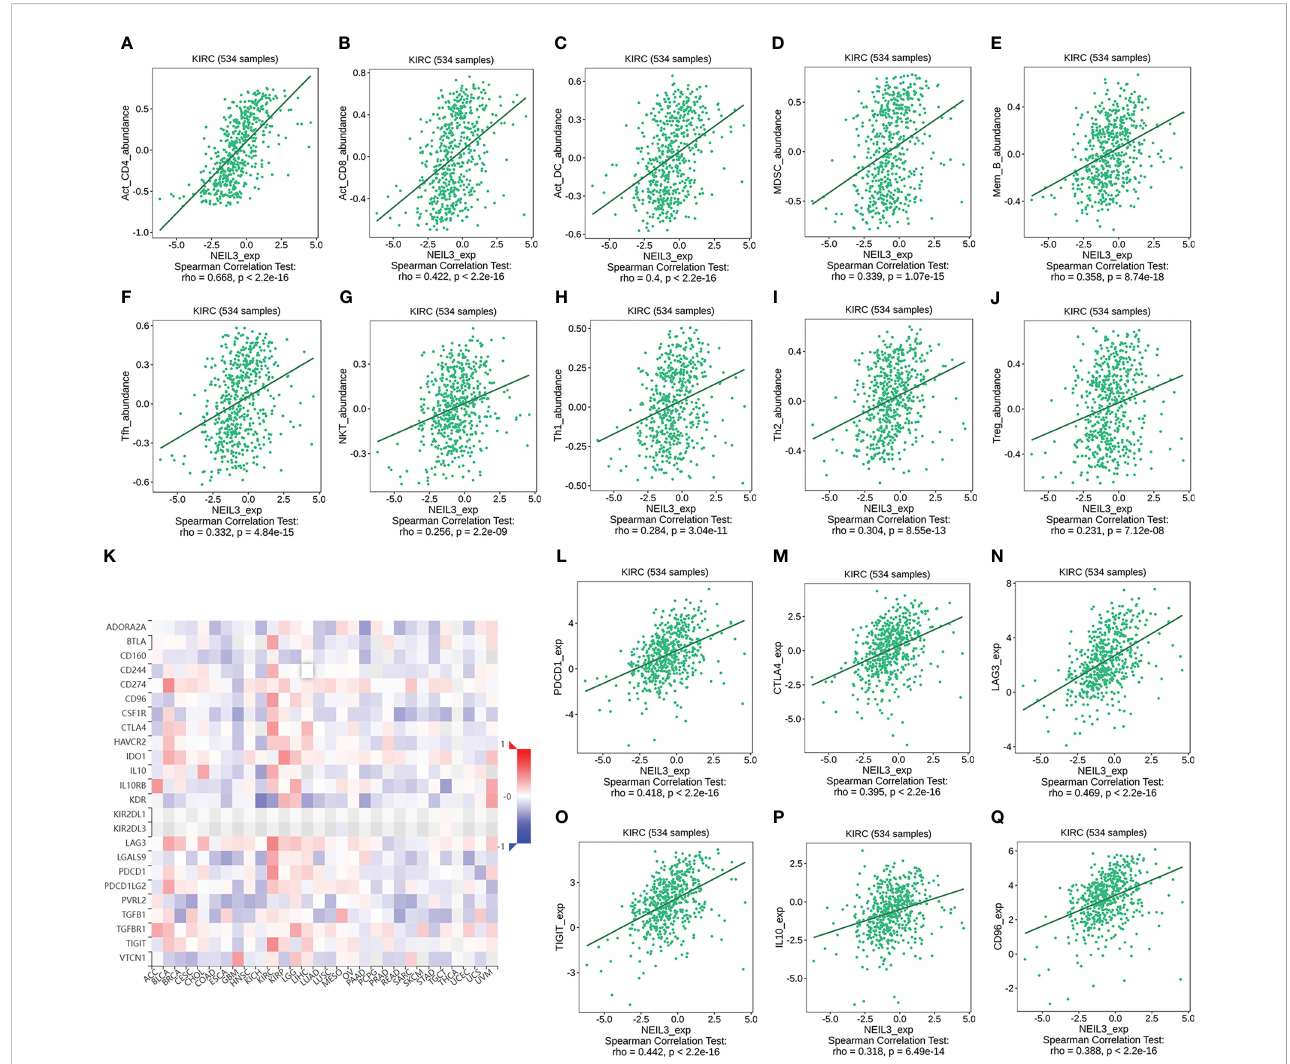
FIGURE 8 (A – J) Correlation analysis between the abundance of tumor-in fi ltrating lymphocytes (TILs) and NEIL3 expression using the TISIDB database. The results show that NEIL3 expression is positively correlated with activated CD4 T cells (r = 0.668, P < 2.2e-16), activated CD8 T cells (r = 0.422, P < 2.2e-16), activated dendritic cells (DCs) (r = 0.4, P < 2.2e-16), myeloid-derived suppressor cells (MDSCs) (r = 0.339, P = 1.07e-15), memory B cell (r = 0.358, P = 8.74e-18), follicular helper T cells (Tfhs) (r = 0.332, P = 4.84e-15), NKT cells (r = 0.256, P = 2.2e-09), Type 1 T helper cell (Th1 cells) (r = 0.284, P = 3.04e-11), Type 2 T helper cells (Th2 cells) (r = 0.304, P = 8.55e-13) and regulatory T cells (Tregs) (r = 0.231, P = 7.12e-08). (K) The heatmap reveals the association between NEIL3 expression and 24 immunoinhibitors across multiple tumors. (L – Q) Scatterplots of the correlations between NEIL3